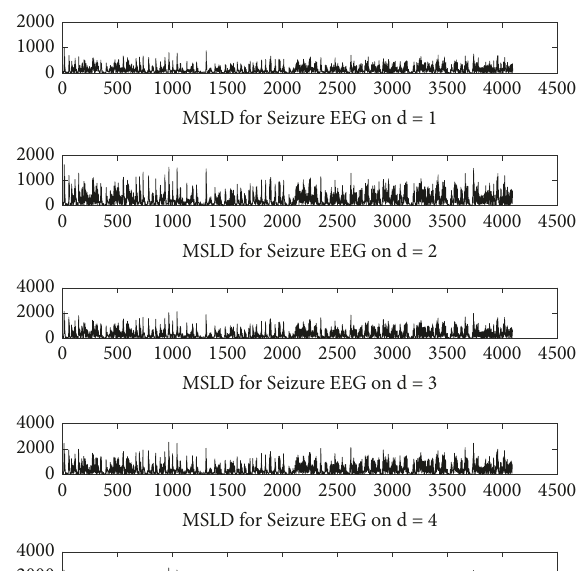
Figure 5: Illustration of 5-fold CV.